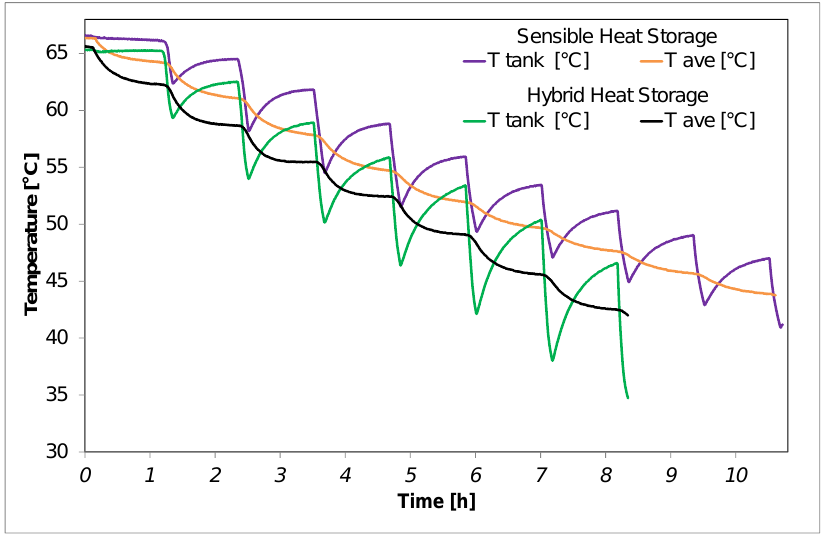
Figure 6. Dynamic evolution of the temperatures inside the TES system in sensible and hybrid configurations obtained under Test A conditions.